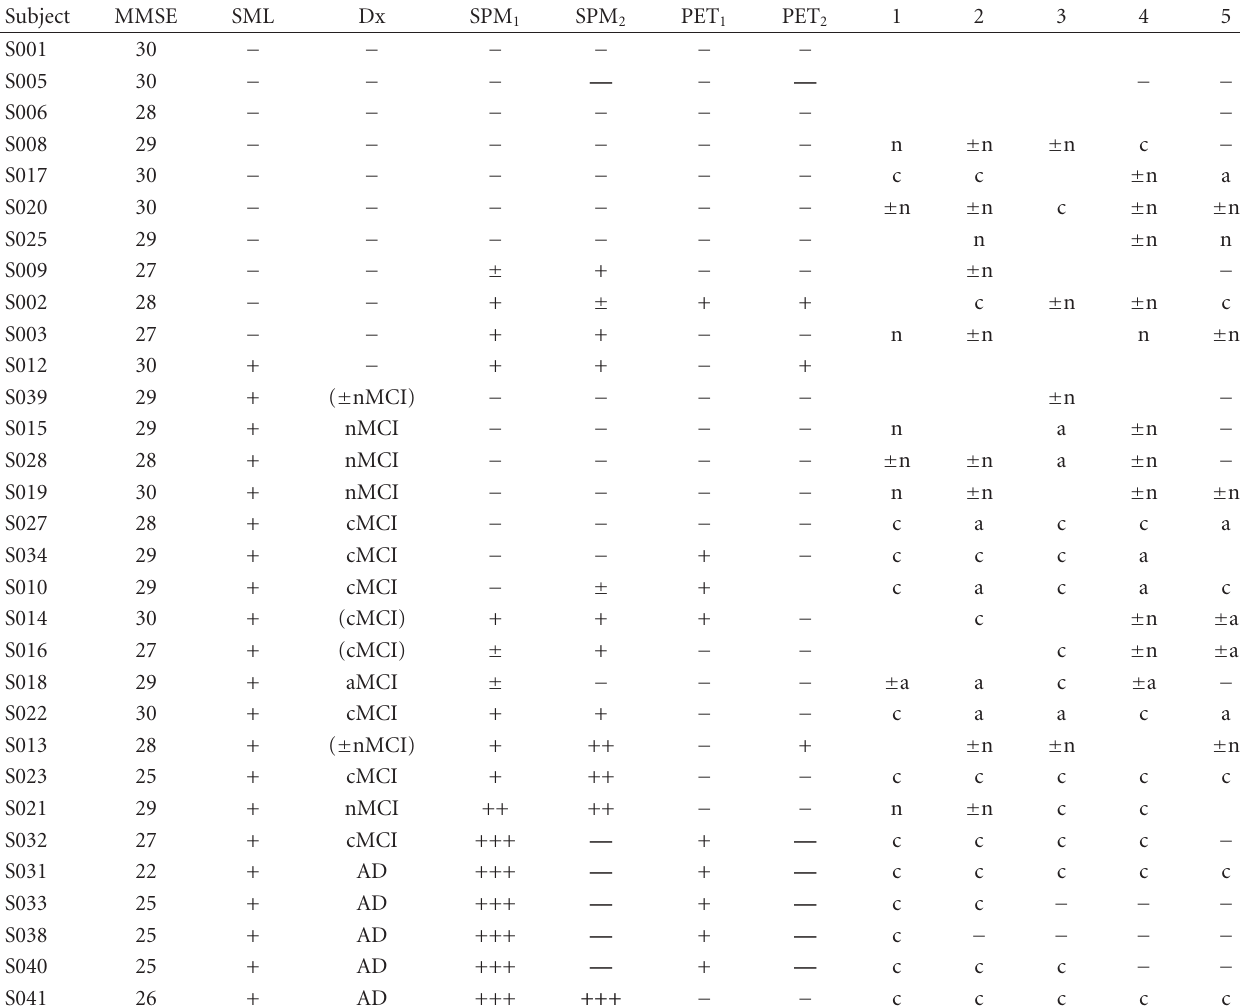
Table 2: Results for subjects enrolled in the MCI early detection